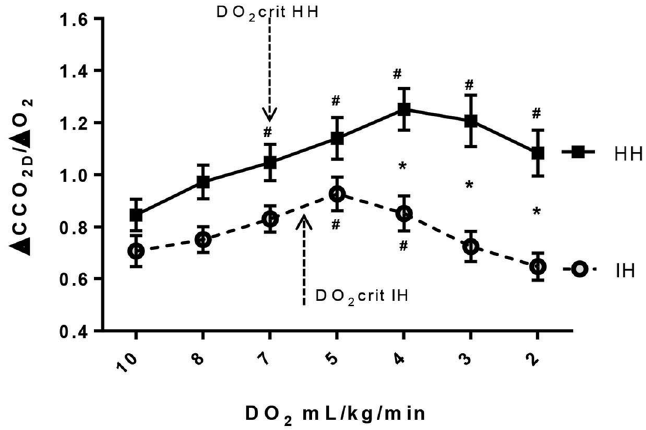
Figure 5. Hindlimb venous-to-arterial CO 2 content difference calculated with Douglas equation (ΔCCO 2D ) over the arterial-to-venous O 2 difference (ΔO 2 ) ratio (ΔCCO 2D /ΔO 2 ) as a function of hindlimb oxygen delivery (DO 2 ) for ischemic hypoxia model (IH) and hypoxic hypoxia model (HH). At DO 2 crit, there was no significantly difference between HH model (1.01 ± 0.06) and IH model (0.87 ± 0.05). * p < 0.006 vs. HH, # p < 0.007 vs. baseline, mixed